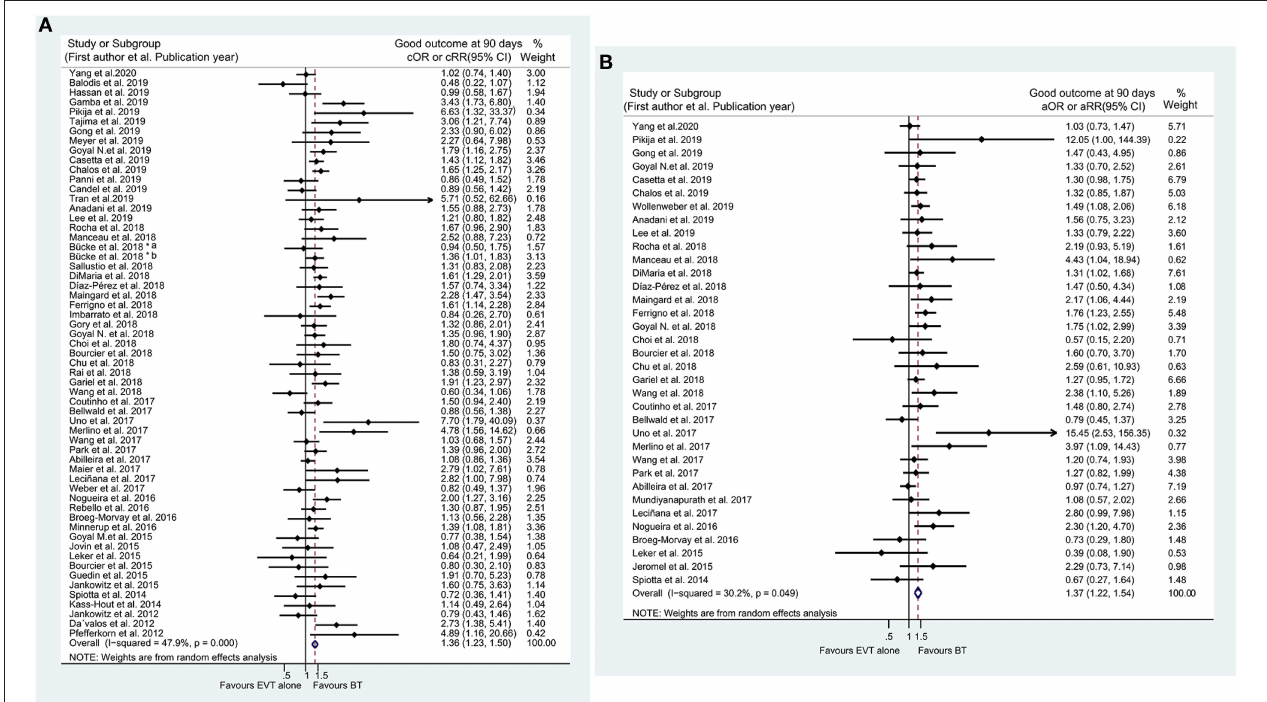
FIGURE 2 | Forest plots of studies assessing good outcome at 90 days in unadjusted (A) and adjusted (B) analysis. ICA, internal carotid artery. *The acute intracranial vessel occlusion patients with (a) or without (b) concomitant ipsilateral ICA-occlusion or high-grade stenosis were investigated, respectively, in the study by Bücke et al.